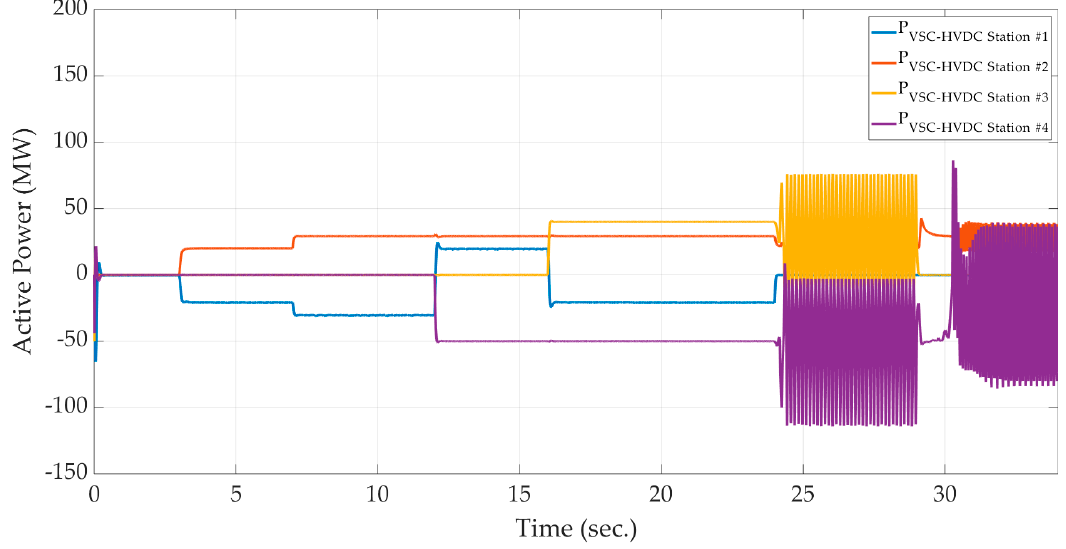
Figure 10. The AC voltage profile of different VSC-HVDC stations in the first scenario.